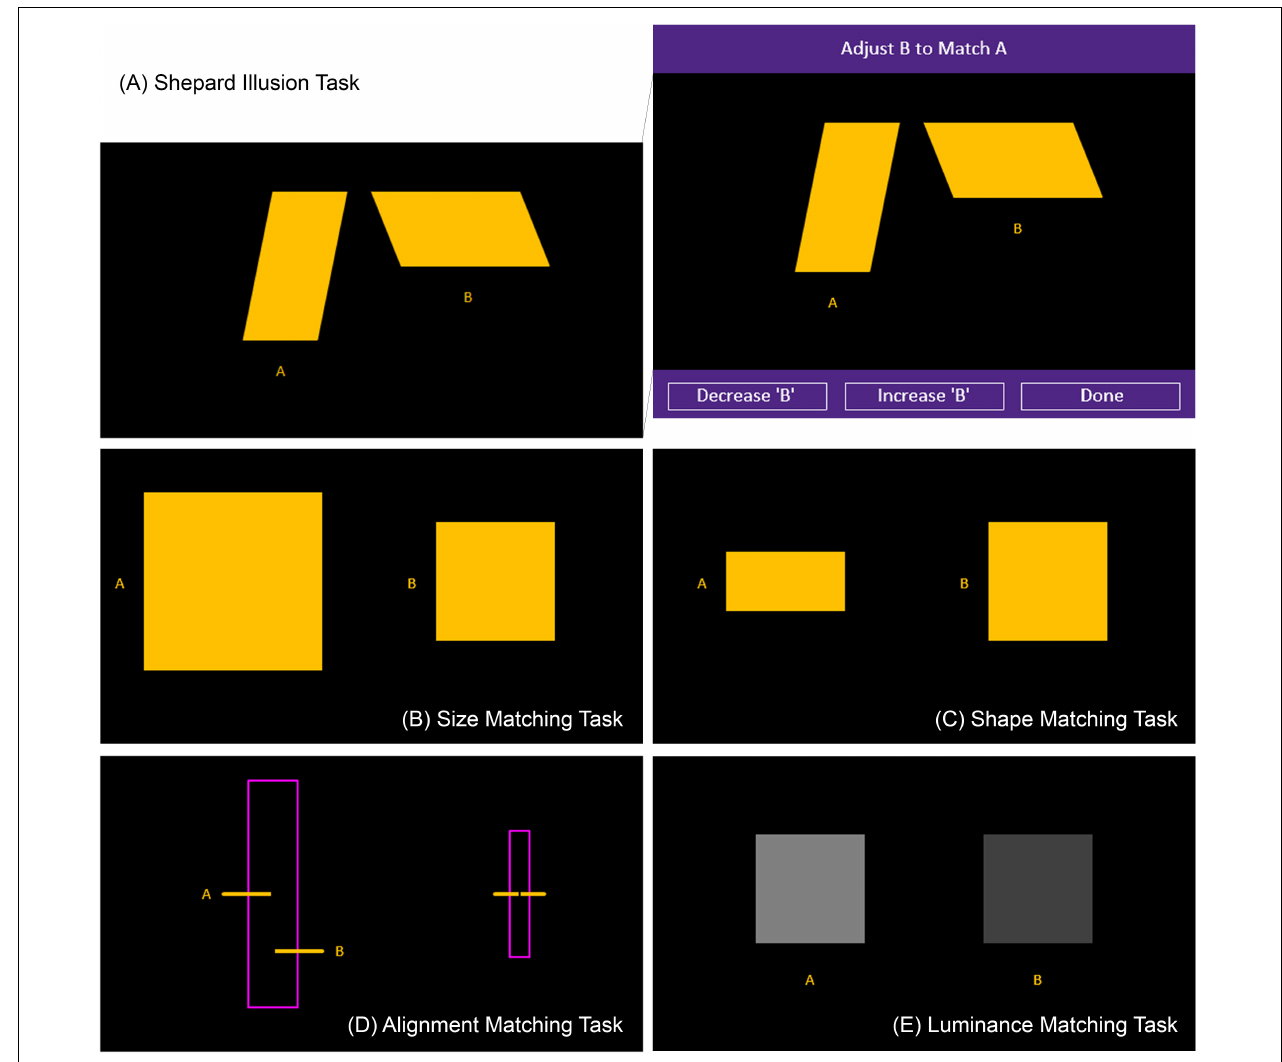
FIGURE 1 | Illusion and control matching tasks. The figure displays the illusion and control matching tasks that were examined. The illusion task consisted of the Shepard illusion (A) . The right side of the top panel (A) demonstrates the full visual display with the buttons at the bottom that the participants used to adjust the comparison stimulus (in this case, the stimulus on the right) to match the standard (in this case, the stimulus on the left). The different tasks (A–E) had similar buttons and differed by the stimuli presented in the black area and the dimensions that had to be matched. The control tasks consisted of size (B) , shape (C) , alignment (D) , and luminance (E) matching